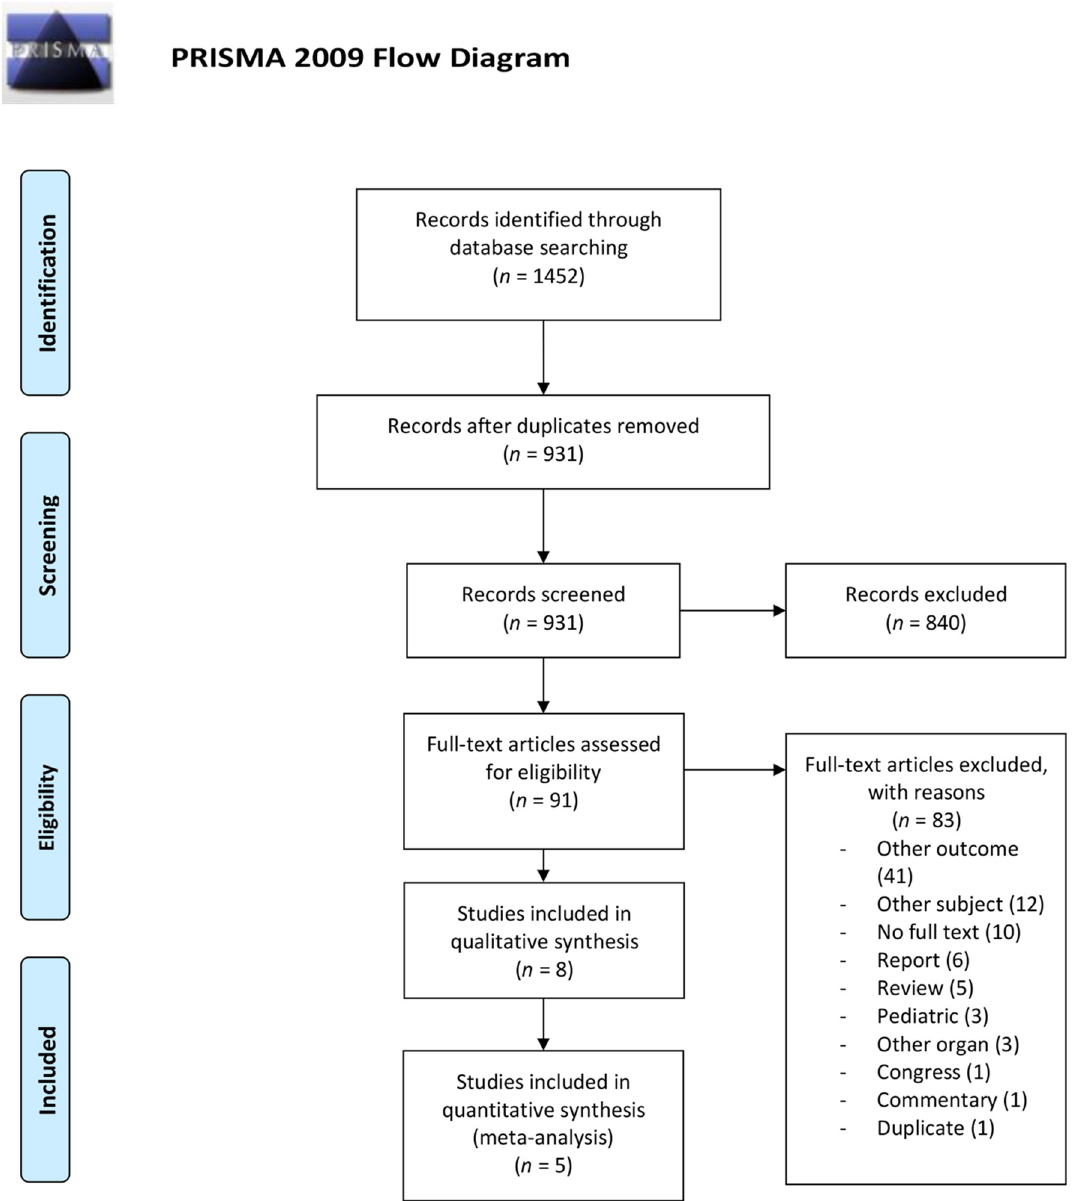
Figure 1. PRISMA (Preferred Reporting Items for Systematic Review’s and Meta-Analysis) flowchart of the systematic review search. Table 1. Overview of the included studies in the systematic review.